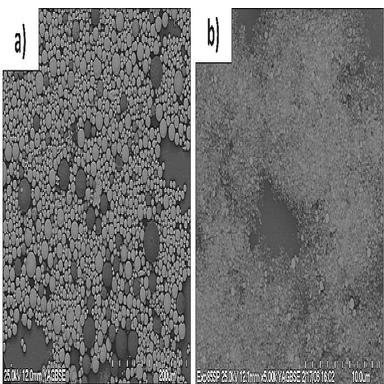
SEM morphologies of a) the separated larger and b) smaller particles of the Al-Ni system.